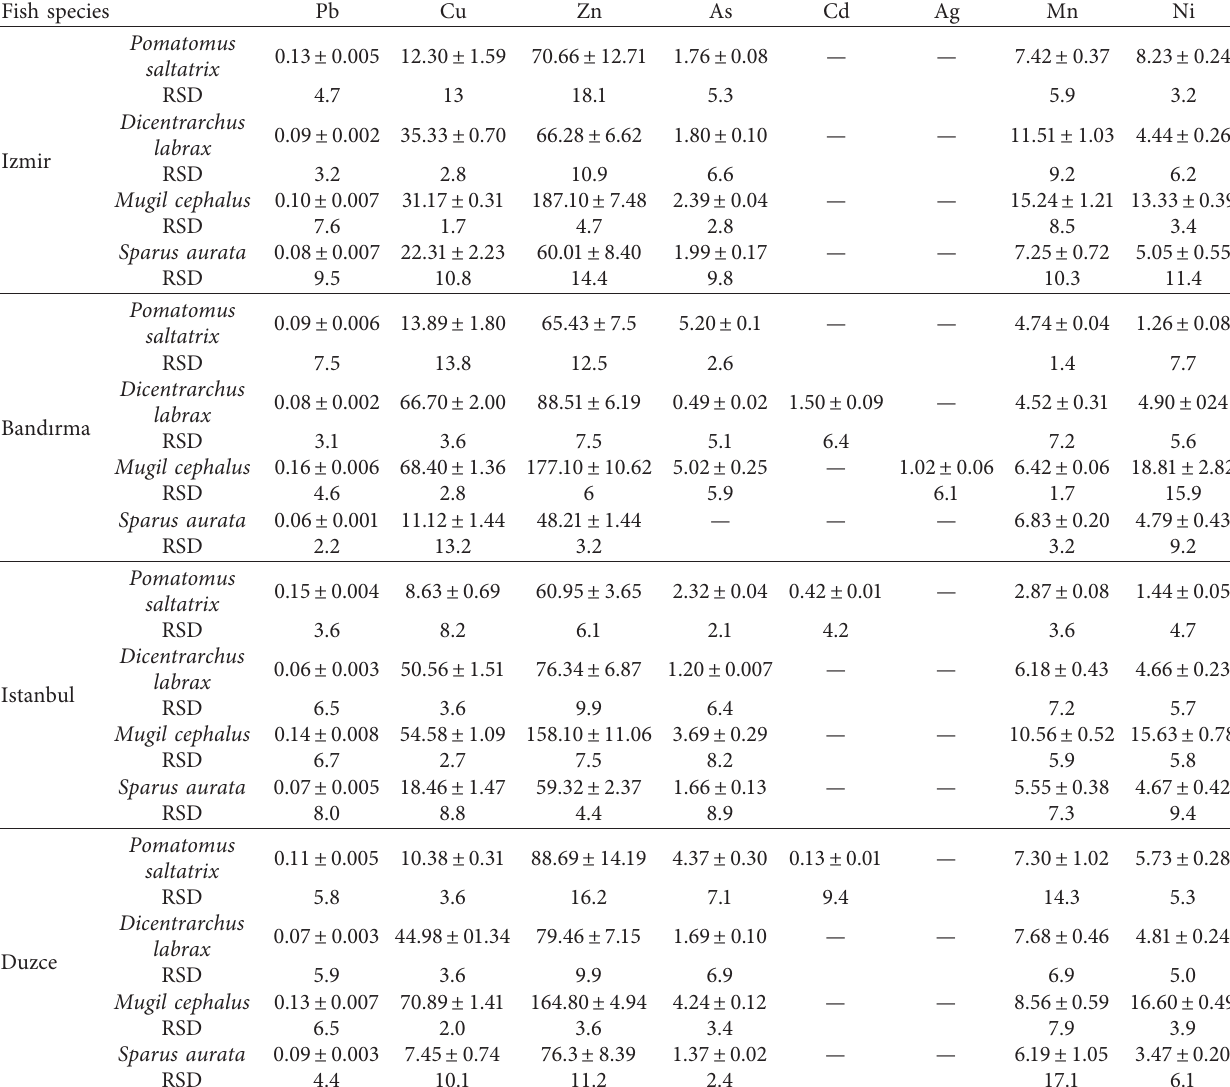
Table 3: Concentration of Pb, Cu, Zn, As, Cd, Ag, Mn, and Ni residues ( μ g/g) in internal organs of fish samples. Fish species Pb Cu Zn As Cd Pomatomus Izmir